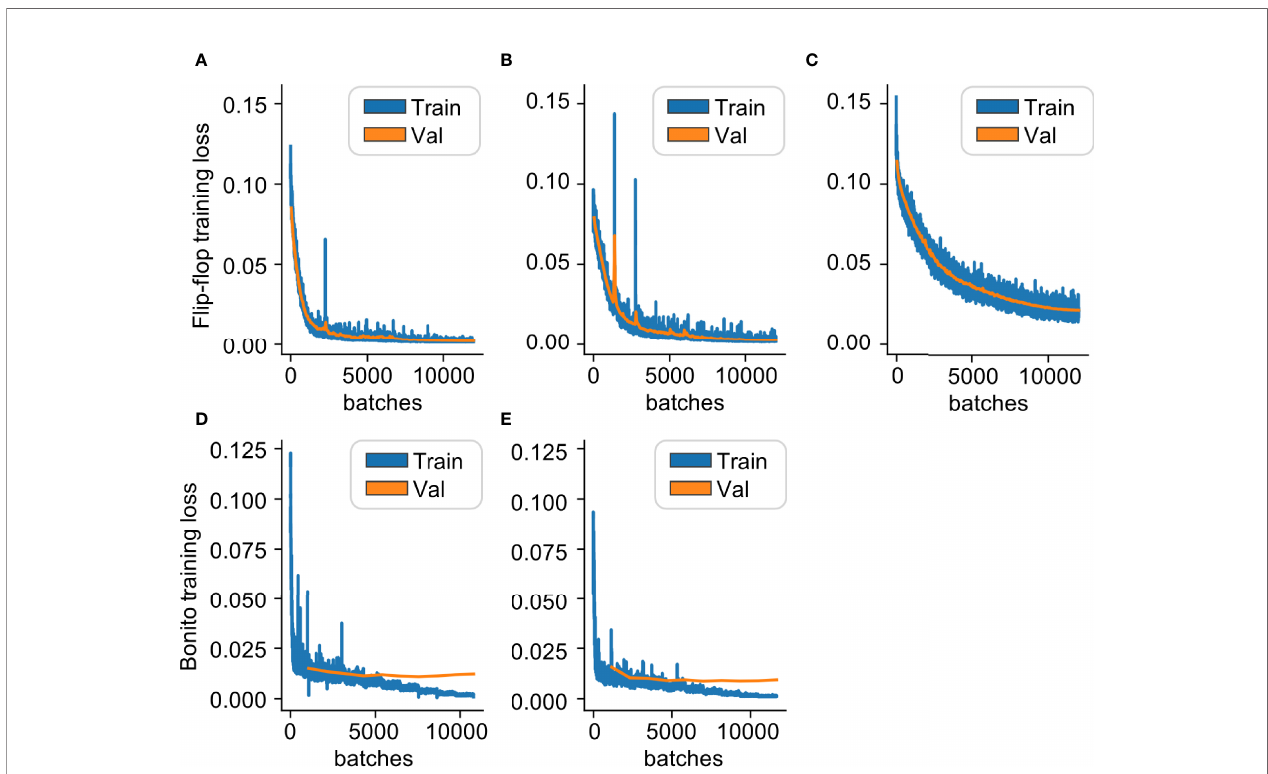
FIGURE 5 | Training HIV-Quasipore basecallers minimized the differences between called reads and the J-Lat 10.6 reference genome. Training and validation loss curves for: (A) R10.3 HAC, (B) R9.4.1 HAC, (C) R9.4.1 fast, (D) R10.3 SUP, and (E) R9.4.1 SUP. All curves consistently and stably decrease as batches increase, indicating that both models were successfully trained and have improved HIV-1-speci fi c basecalling